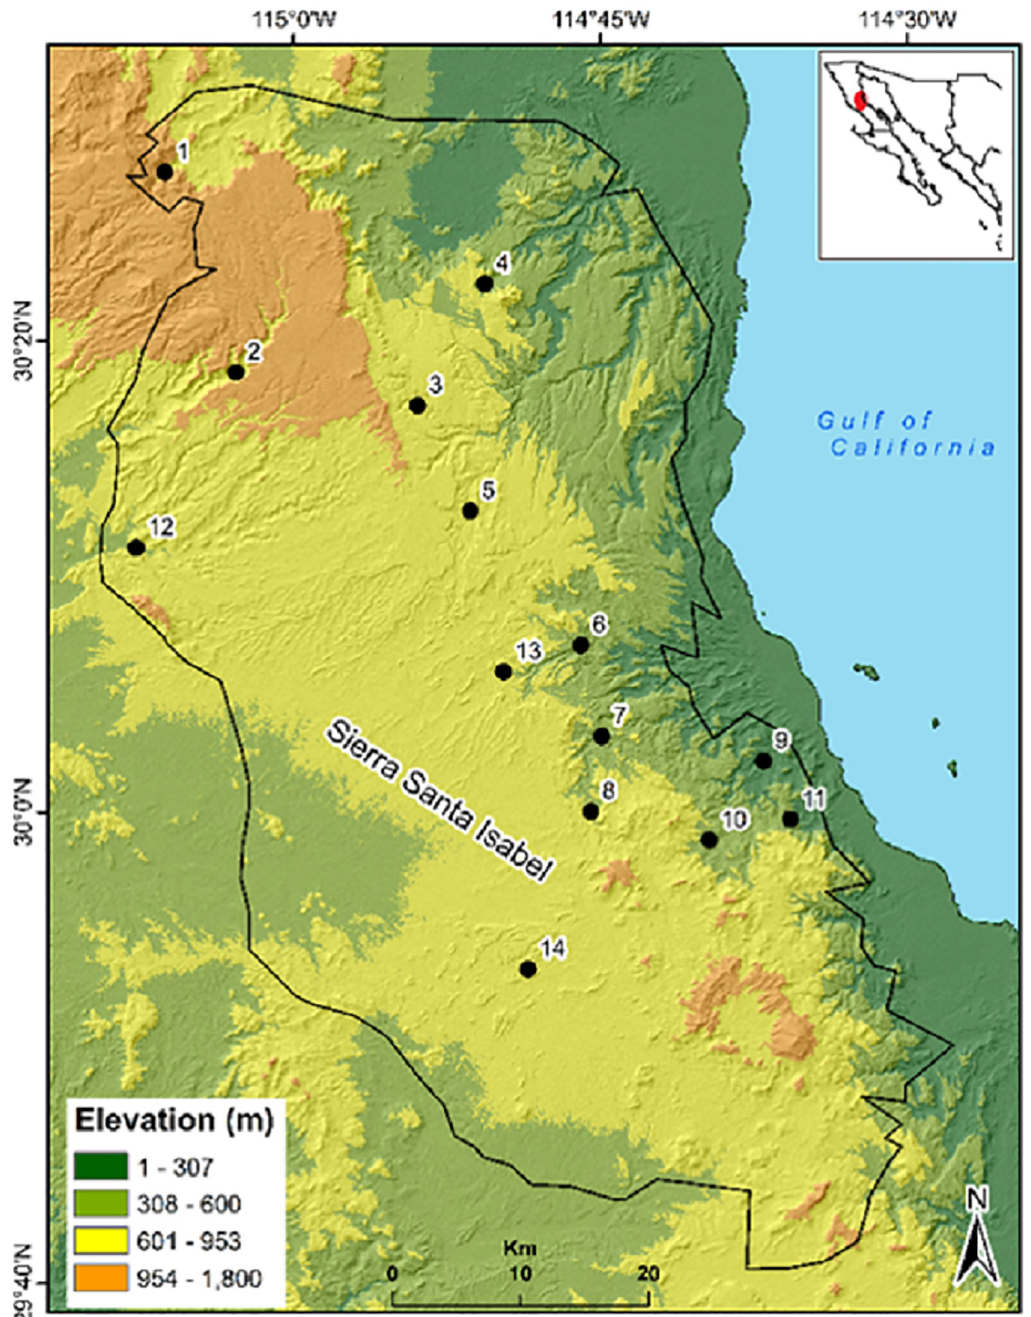
Fig 2. Location of waterholes in Sierra Santa Isabel, Baja California. 1. Matomi, 2. Grande, 3. Las Blancas, 4. Canelo, 5. Hemes, 6. Zamora, 7. Cordero, 8. Volca´n, 9. Miramar, 11. Palmito, 12. San Agustı´n, 13. Peralta, 14.